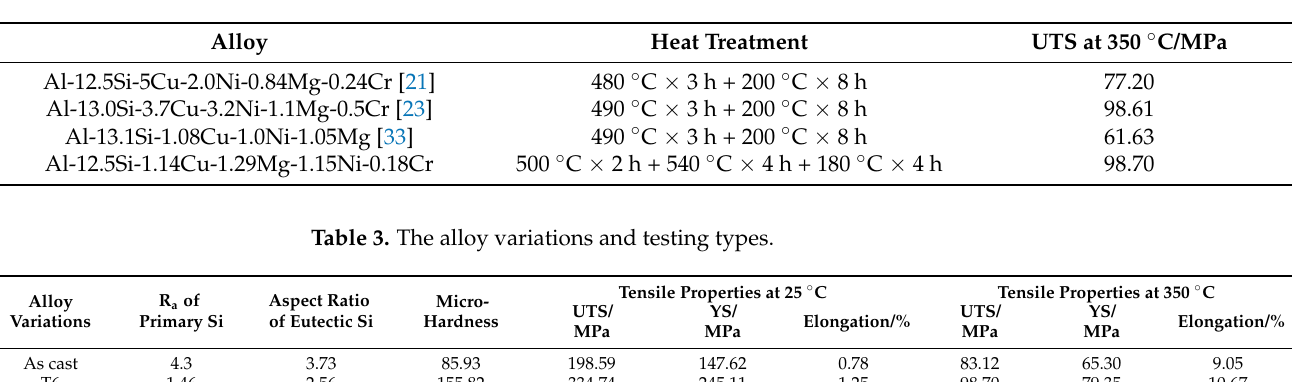
Table 2. Tensile properties of T6 alloys at 350 ◦ C.